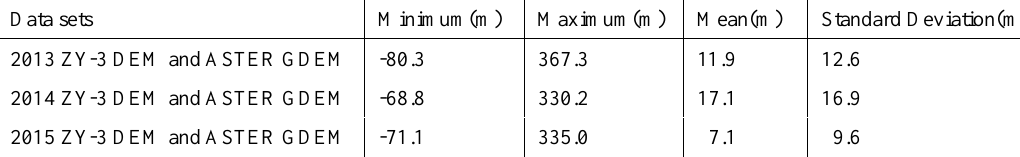
Table 3 The statistical results of elevation changes between ZY-3 DEMs and ASTER GDEM.